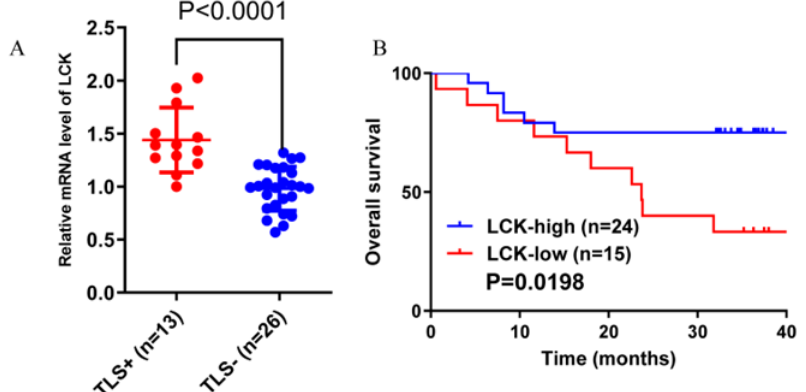
Figure 7. Xijing Hospital data. ( A ) The expression of LCK in the TLS+ group was significantly higher than that in the TLS-group. ( B ) The overall survival of patients in the high LCK expression group was significantly higher than that of patients in the low LCK expression group.